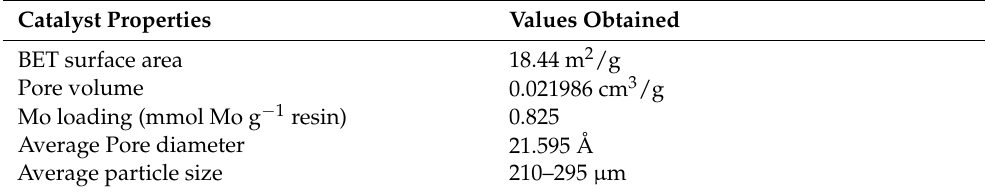
Table 1. Properties of polybenzimidazole supported Mo(VI) (i.e., PBI.Mo) catalyst. Catalyst Properties